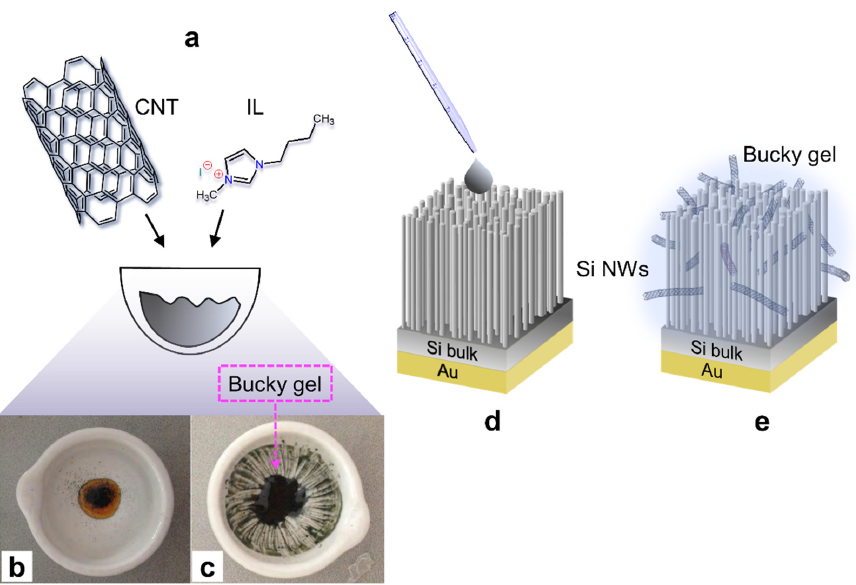
Figure 2. ( a ) Schematic illustration for the bucky gel realization ( b ) mixing 5.7 mg of SWCNT into 1 mL of ionic liquid into an agate mortar to be pestered for 10 min until ( c ) gel formation. ( d ) The bucky gel is drop casted onto the Si NWs array with a metal back contact to form ( e ) the hybrid IL-CNT/NW platform after its full coverage in the bucky gel.